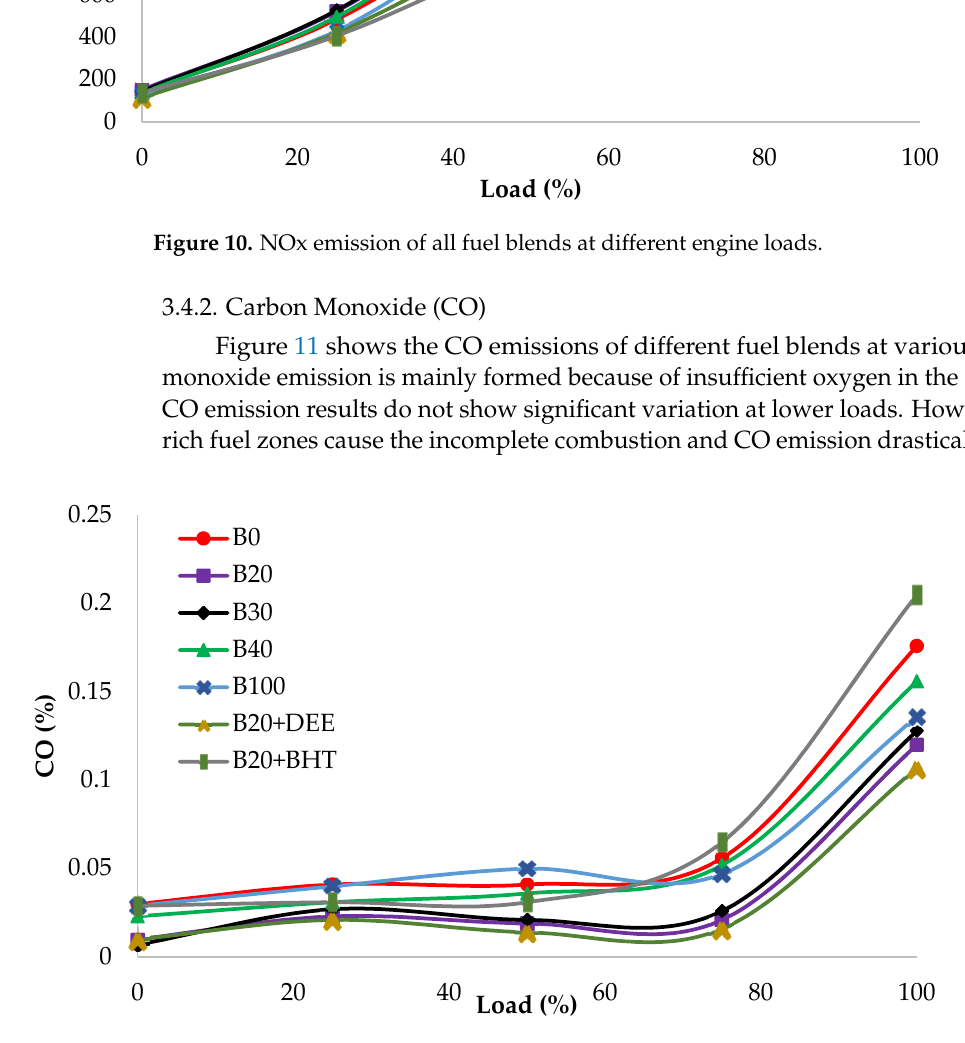
Figure 11. CO emissions of all fuel blends at different engine loads.